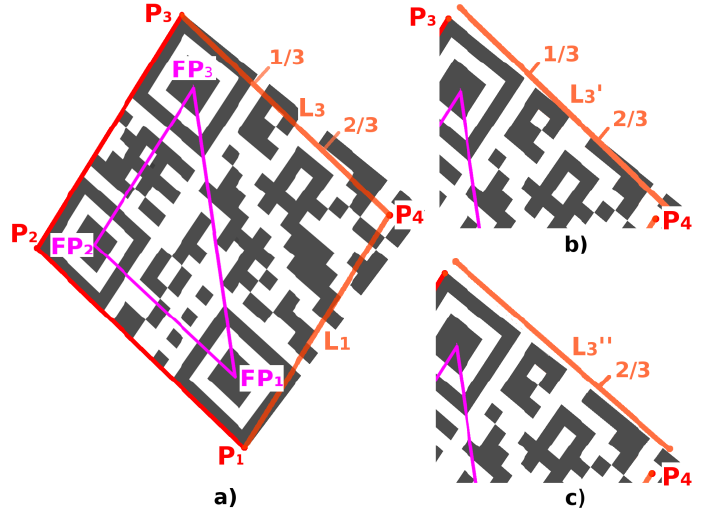
Figure 13. Perspective distortion: ( a ) initial estimate of the point P 4 and lines L 1 , L 3 ; ( b ) first shift of the line L 3 ; ( c ) second shift of the line L 3